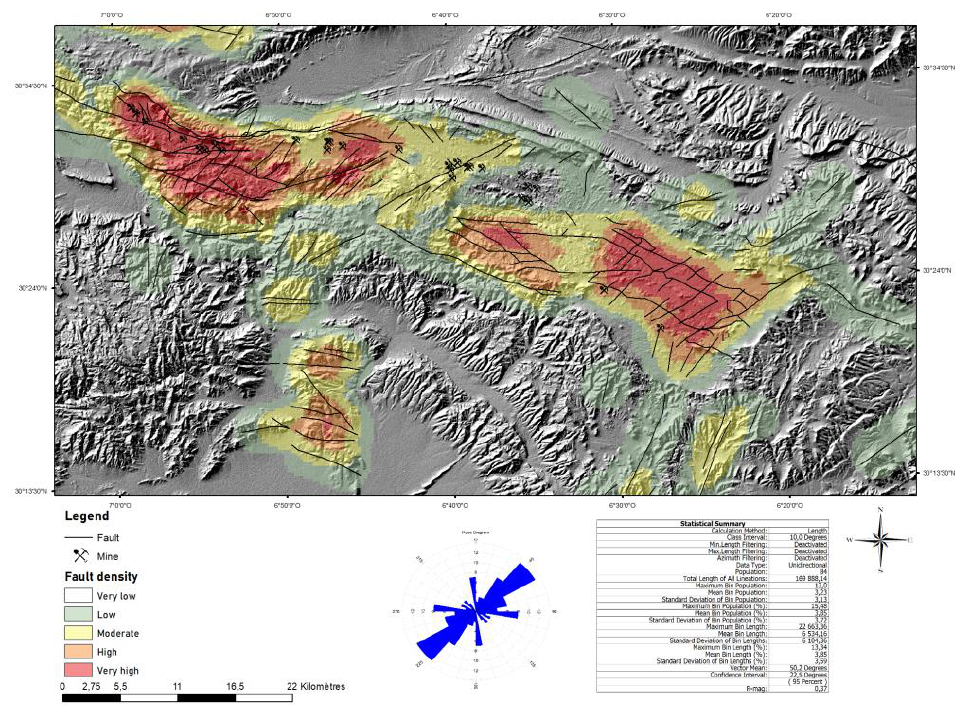
Figure 11. Geological fault density map of Bou Azzer inlier.